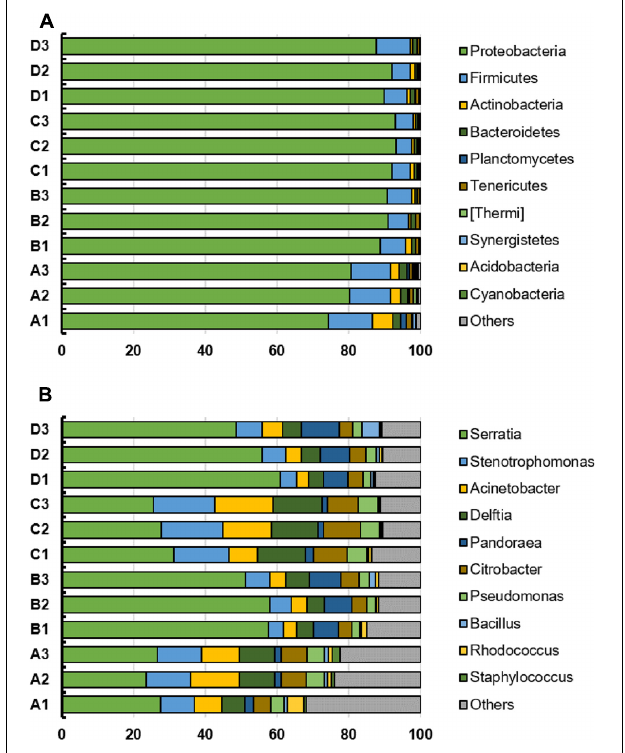
FIGURE 2 | (A,B) Top 10 phyla and genera in individual bacterial communities from the B. napus L. phyllosphere for the four treatments (A, B, C, D). The x -axis indicates the relative